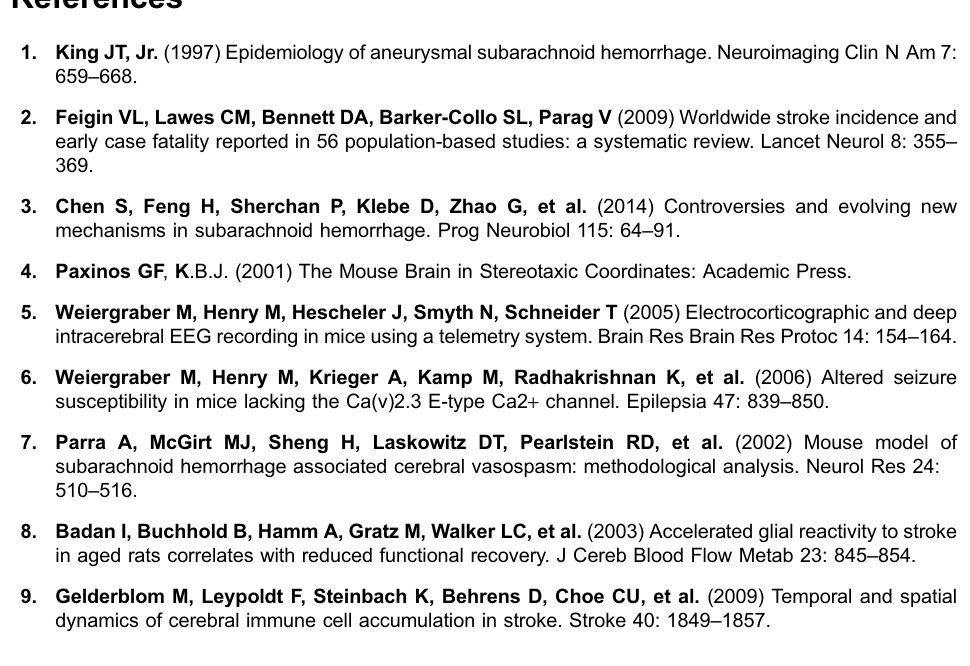
S3 Table. Cerebral and cerebellar perfusion values during DCI. S3 Table summarizes cerebral and cerebellar rCBF perfusion values 6, 12, 24 and 72 hour after ictus (Abbreviations: conc: Concentration of moving blood cells, d: day, rCBF: regional cerebral blood flow; SAH: subarachnoid hemorrhage, Saline: Saline-injection group, SEM: standard error of